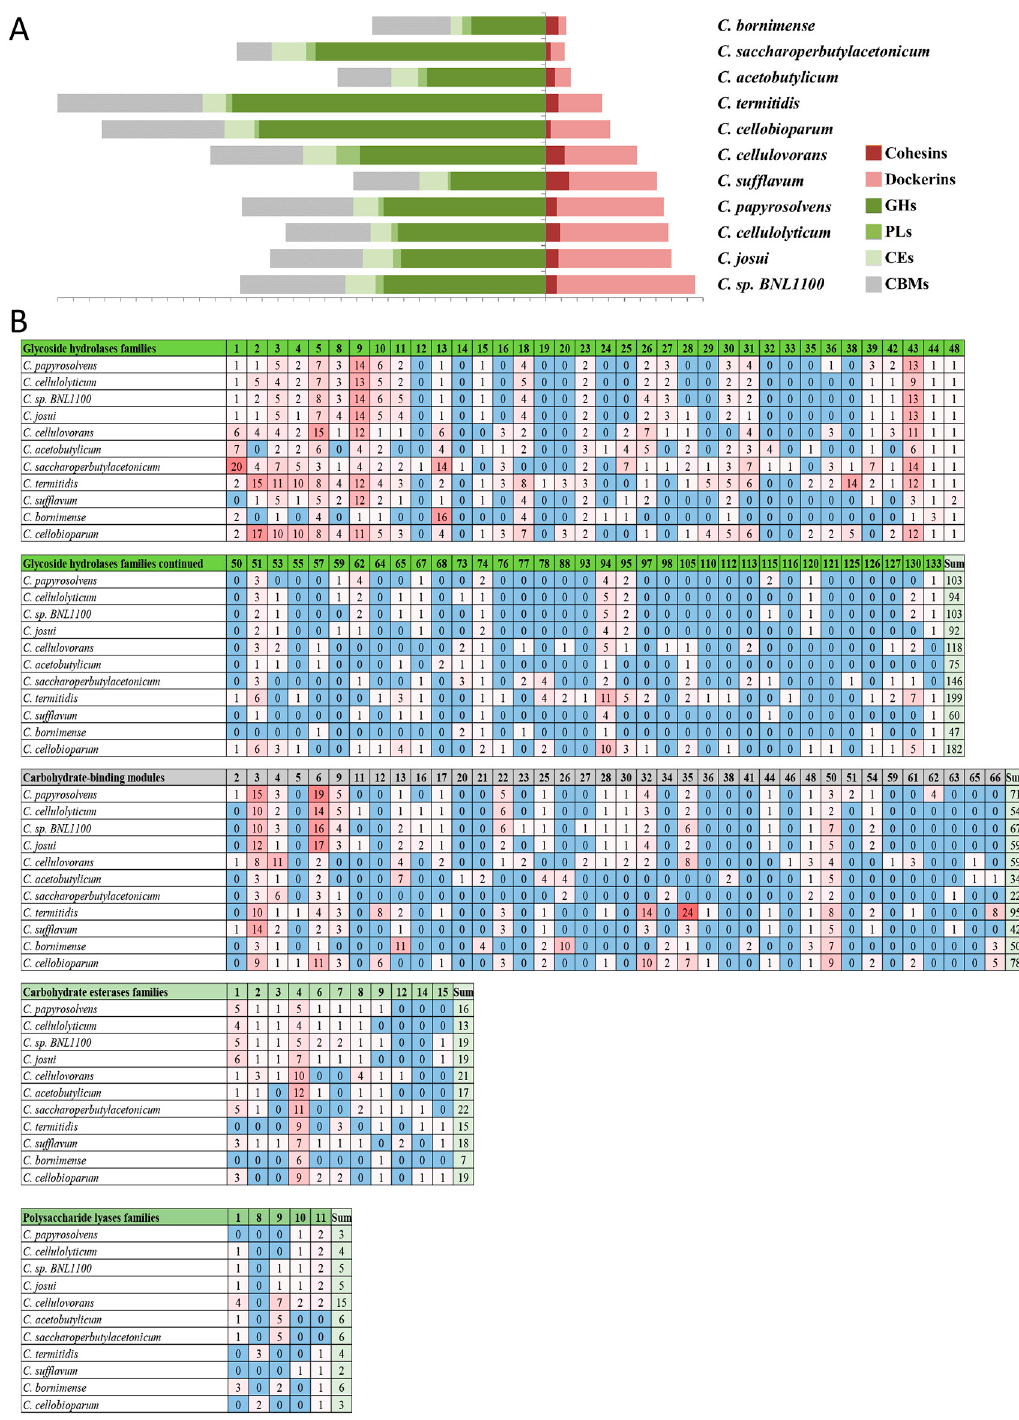
Figure 7. Frequency of CAZY modules identified in mesophiles. ( A ) Number of Carbohydrate-Active enZYmes (CAZyme modules) is denoted for each genome of the mesophilic clostridia. Precise numbers are available in Table 1. ( B ) A detailed count of CAZYmes and their assignment to the different family types. Glycoside hydrolases (GHs), polysaccharide lyases (PLs), carbohydrate esterases (CEs), carbohydrate-binding modules (CBM).